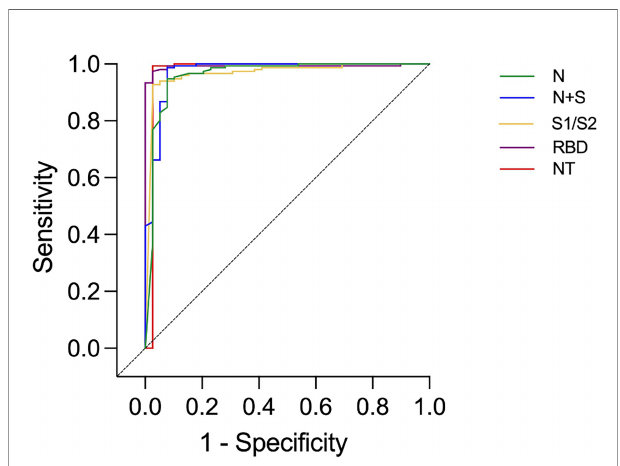
FIGURE 3 | ROC curves presenting results from different commercial IgG- assays and neutralizing antibody titers (NT) in health care workers with and without veri fi ed infection at time-point 4. Identity line